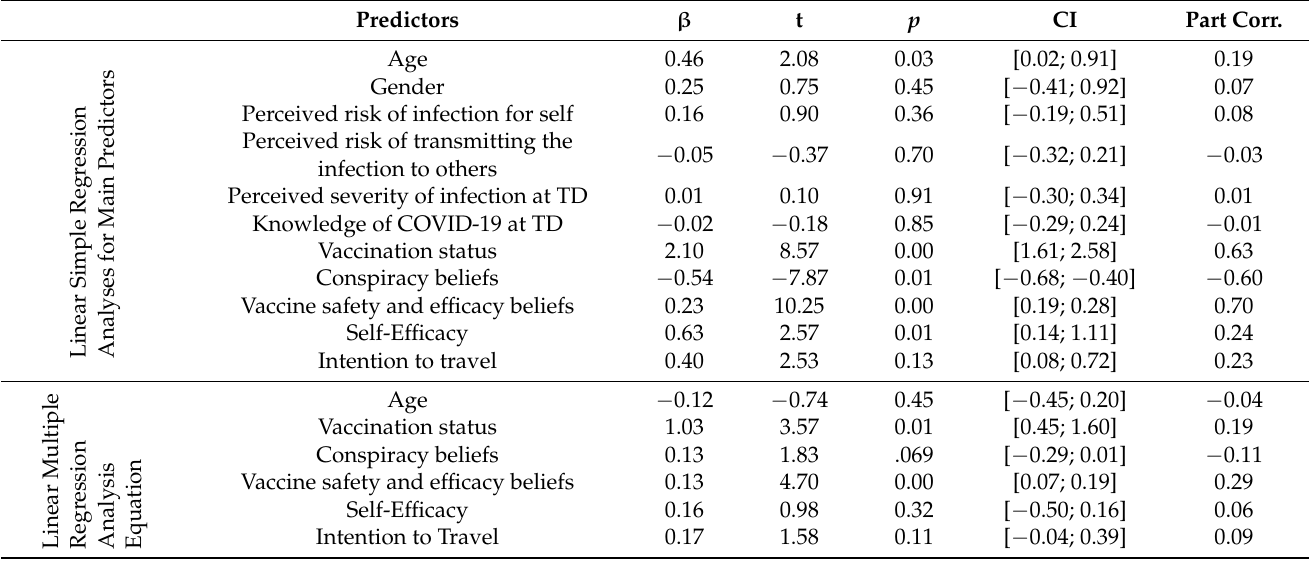
Table 4. Regression Analysis of Predictors of the Intention to Vaccinate against COVID-19 for Travel. Predictors β